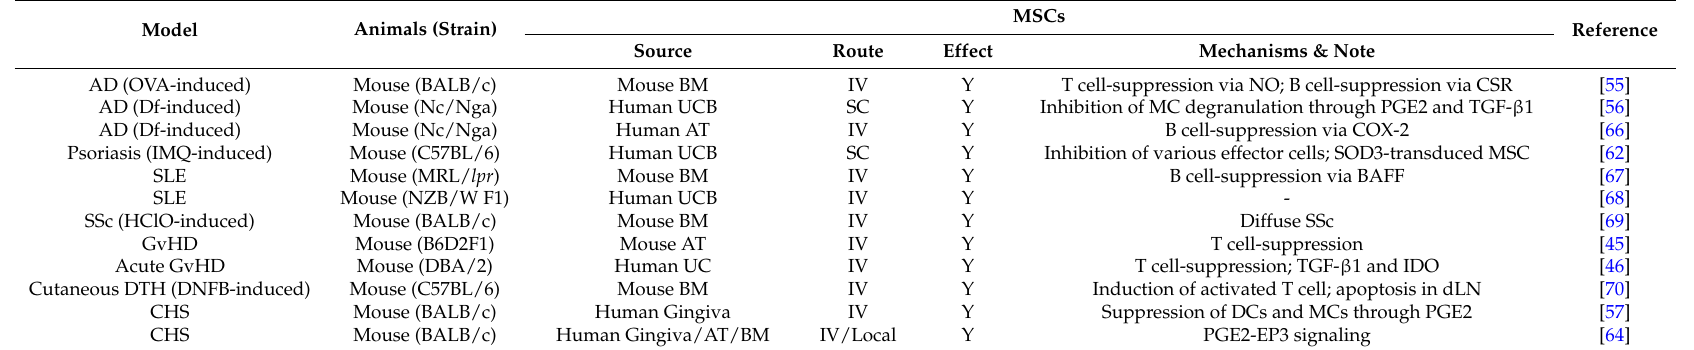
Table 1. Effects of MSCs on experimental animal models of inflammatory skin